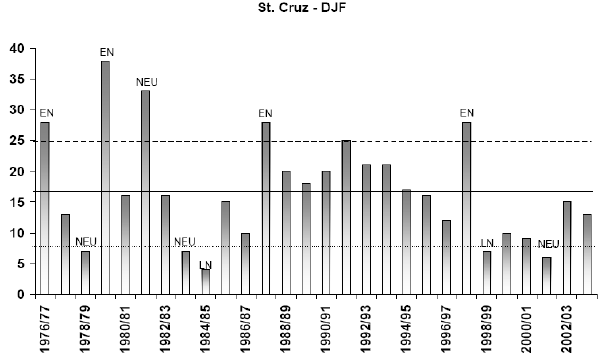
Fig. 2. Frequency of SALLJ detected according the Bonner crite- rion 1 during DJF season in Santa Cruz- Bolivia. The full, dashed and dotted lines represent the mean, one standard deviation above normal and one standard deviation below normal, respectively. The abbreviations EN, LN and NEU above of the bars indicate El Ni ˜ no, La Ni˜na and neutral years, respectively.